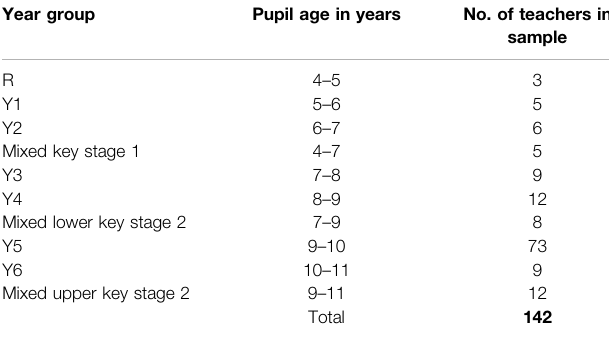
TABLE 1 | Age groups taught by teachers in the